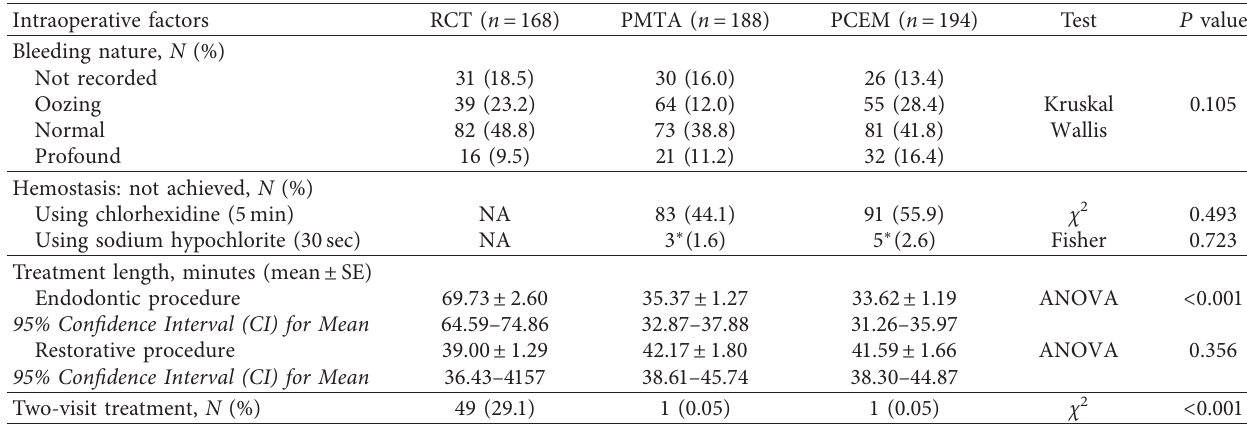
Table 3: Comparison of intraoperative conditions in the three study arms.